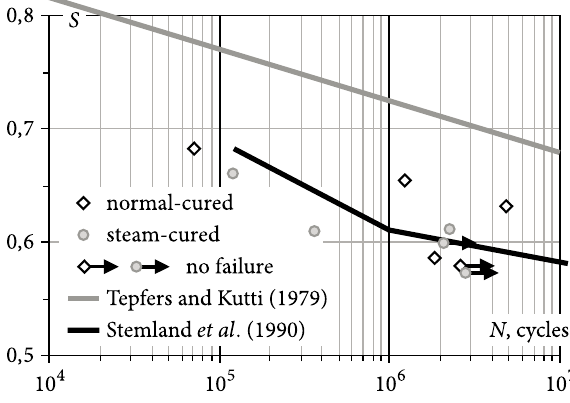
Fig. 4. The Wöhler ’s diagram of compressive specimens cured under different conditions